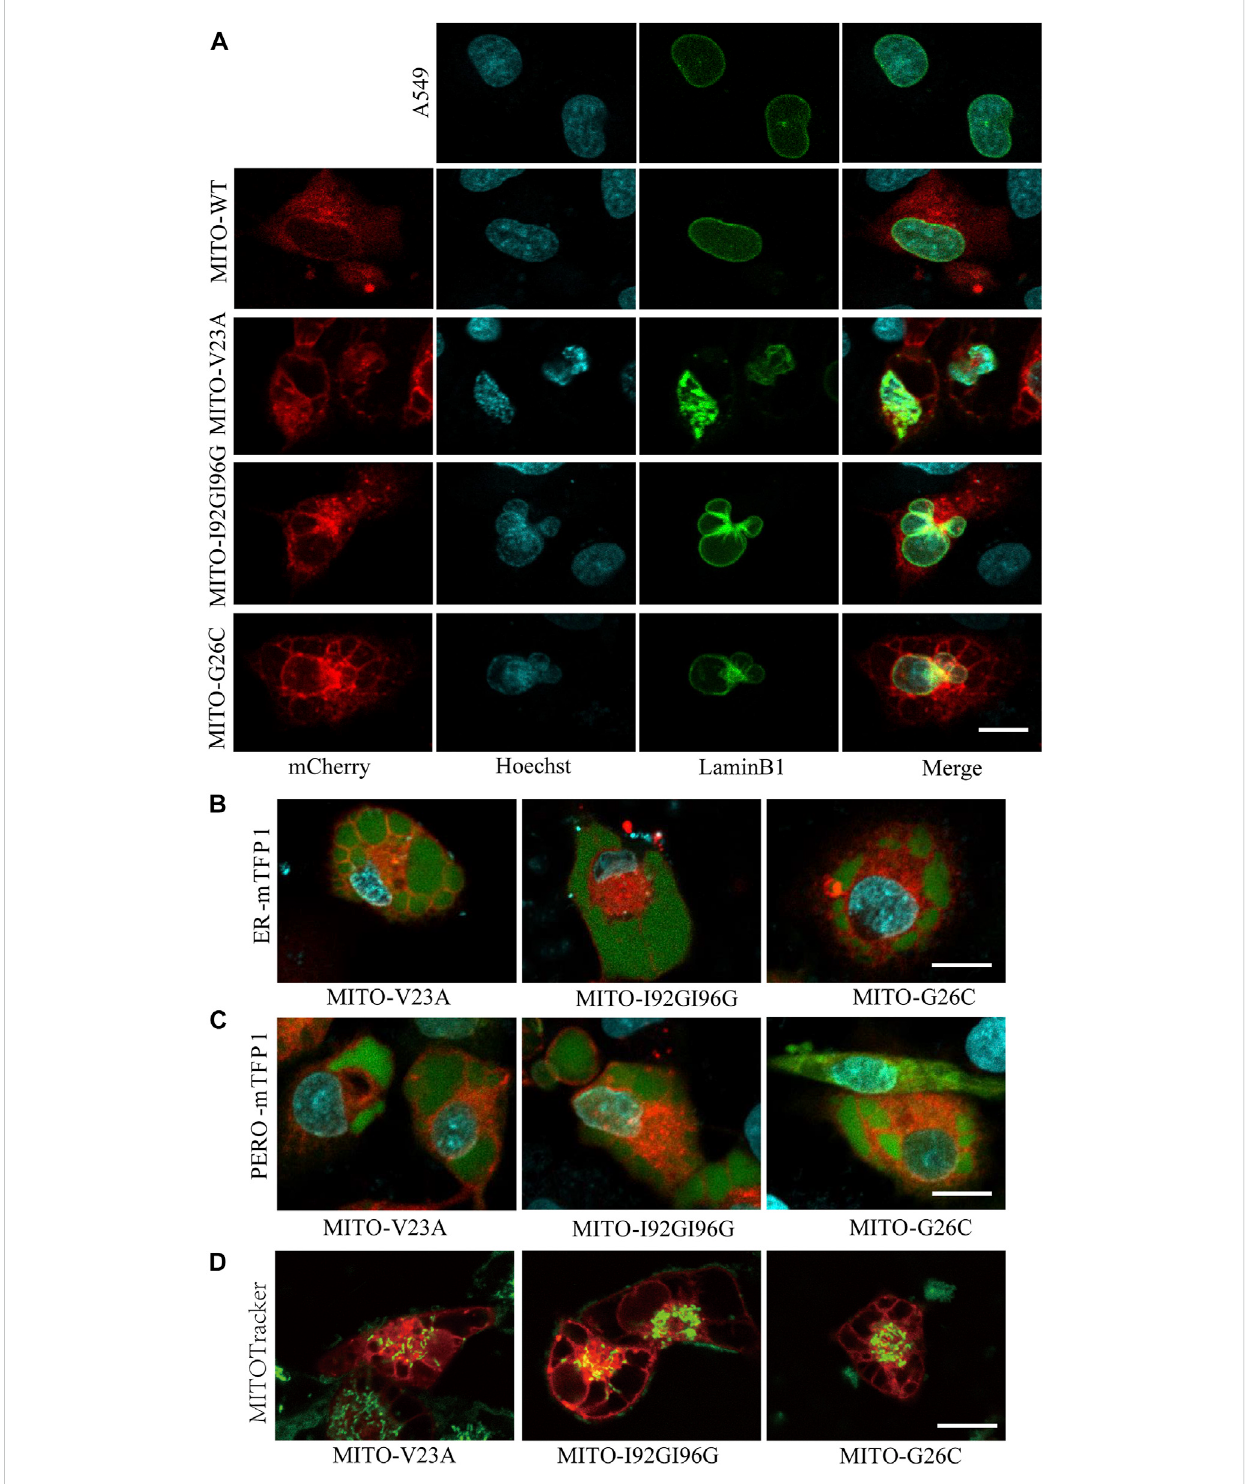
Mitochondrial expression of MscL induced cytoplasmic vacuolization in A549 cells. (A) Confocal imaging of nucleus morphology of MscL- expressing A549 cells visualized with overexpression of LaminB1 (Ne) protein and Hoechst (DNA) staining. (B) and (C) Morphology of mTFP1-marked ER and PERO of A549 cells with cytoplasmic vacualization. (D) MITOTracker indictes the mitochondrial morphology of vacuolated A549 cells. Scale bars: 10